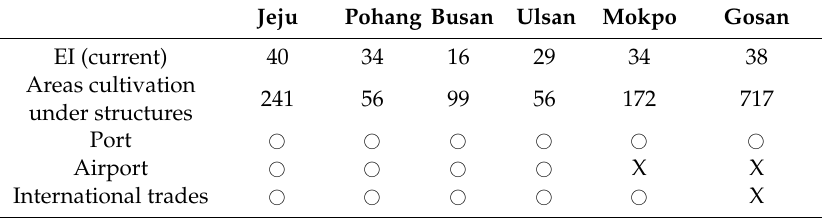
Table 2. List of most dangerous cities exposed to red imported fire ant